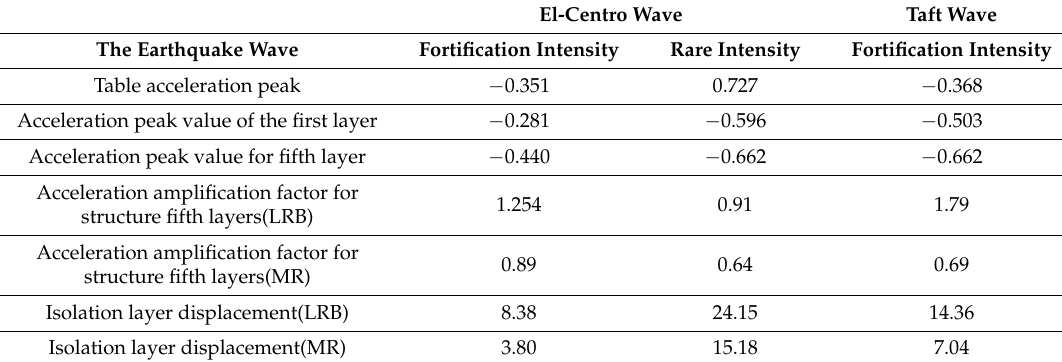
Table 5. Peak value for structure acceleration and isolation layer displacement response under lead rubber bearing (LRB) isolation and seismic level 8.